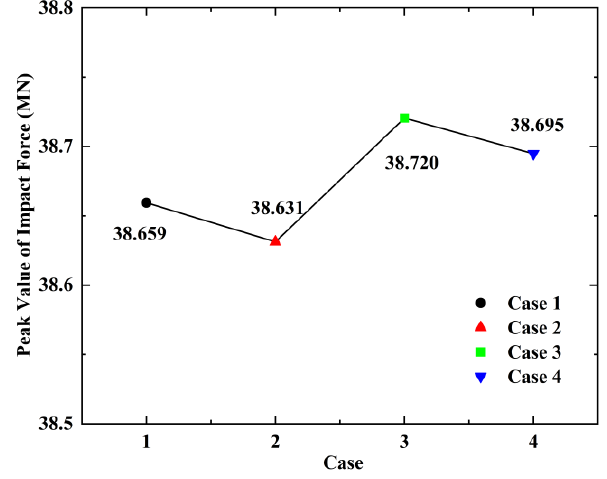
Figure 28. Peak values of impact force in different cases.